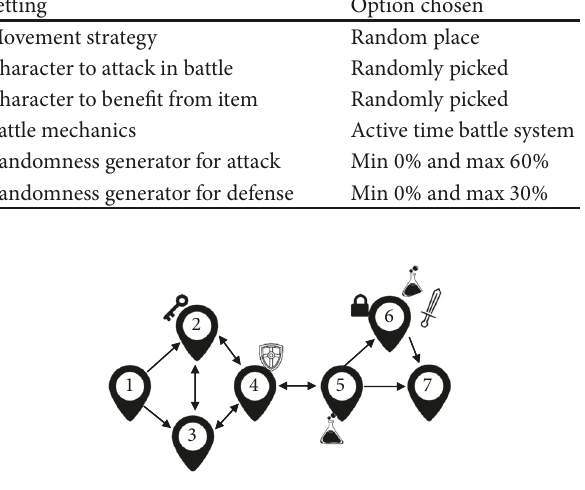
Figure 7: World map for the adventure